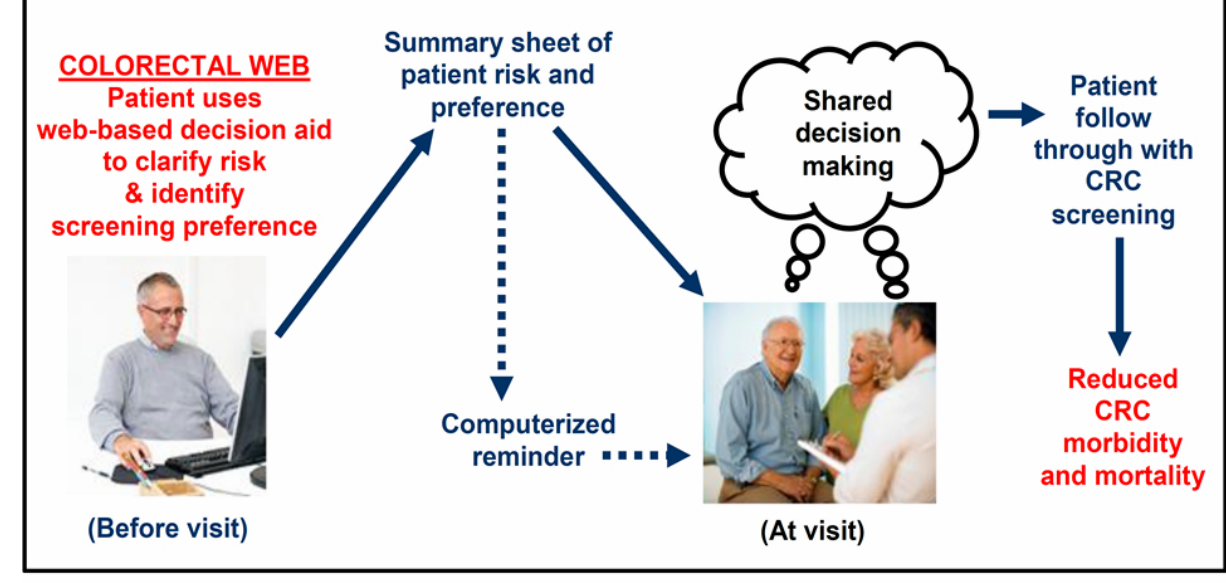
Figure 3. Linkage of colorectal Web to clinical encounter (solid lines show a sequence where the patients may print out their summary sheets to take to their clinicians; dotted lines show a sequence where the computerized reminder also generates the summary sheet for